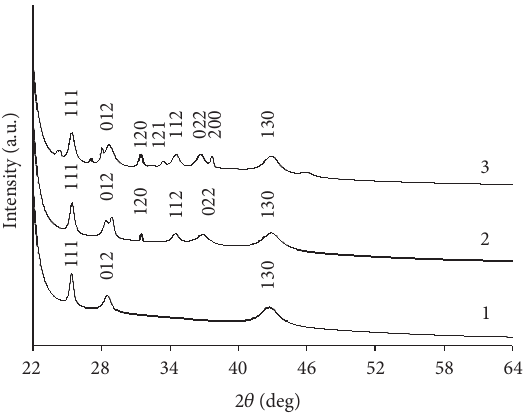
F 5: X-ray diffractograms of the